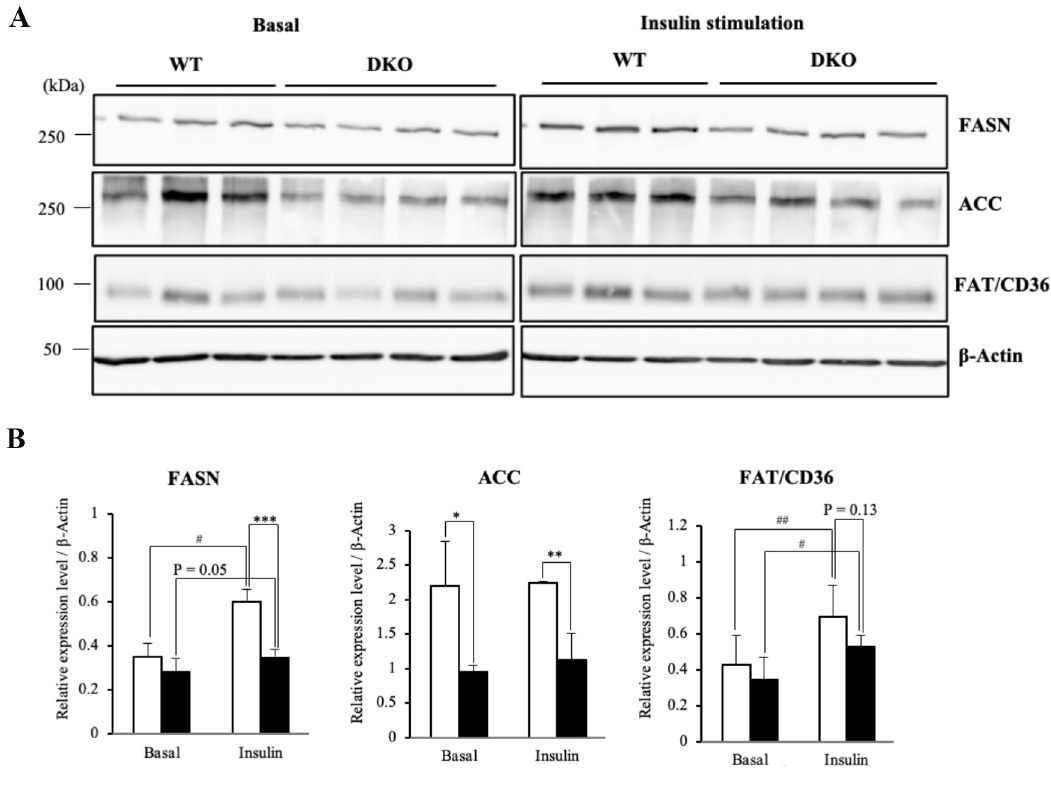
Fig 7. Induced levels of lipogenic proteins after insulin stimulation were lower in DKO hepatocytes. ( A) Expression levels of FASN, ACC, and FAT/CD36 in hepatocytes at 360 min after insulin stimulation were analyzed by immunoblotting. ( B ) Expression levels of lipogenic molecules are presented by measuring band intensities after correction with those of β -Actin. Open and closed bars indicate WT and DKO hepatocytes, respectively. The numbers of mice examined were WT, n = 3; DKO, n = 4. Data are expressed as means ± S.D. � P < 0.05, �� P < 0.01 and ��� P < 0.001 as compared between WT and DKO hepatocytes. # P < 0.05 and ## P < 0.01 as compared between basal and insulin stimulation.